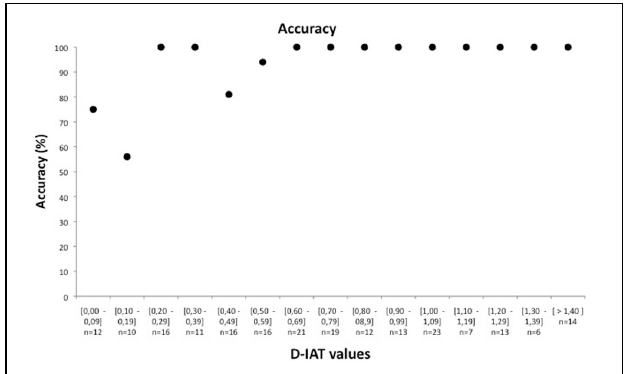
FIGURE 1 | Classification accuracy as a function of the D-IAT value. Data from eight validation experiments, for a total of 209 subjects, were used to calculate accuracy in identifying the true autobiographical memory on the basis of the D-IAT value. D-IAT values have been grouped in bins of 0,1. In the Y axis, the number of participants for each bin is